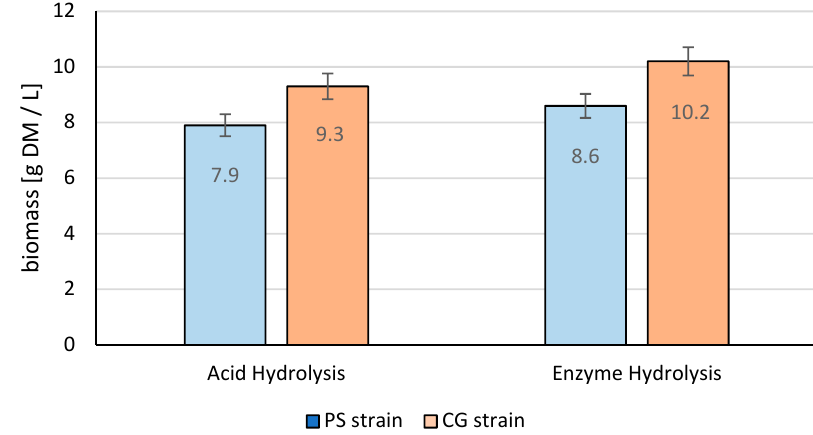
Figure 1. Pichia stipitis (PS) and Candida guilliermondii (CG) biomass concentrations after 48 h of cultivation in acid hydrolysate (AH) or enzymatic hydrolysate (EH). Error bars show 5% deviations. The highest biomass concentration (10.2 g DM/L) was observed for CG cultivated in EH. When